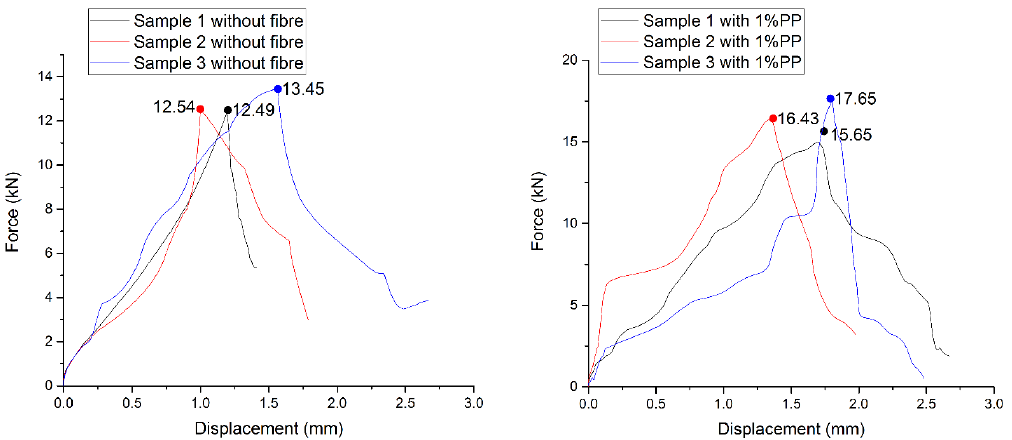
Figure 18. Results after 28 days for the short column (7 layers) without any time lapse between printed layers and without post-curing.